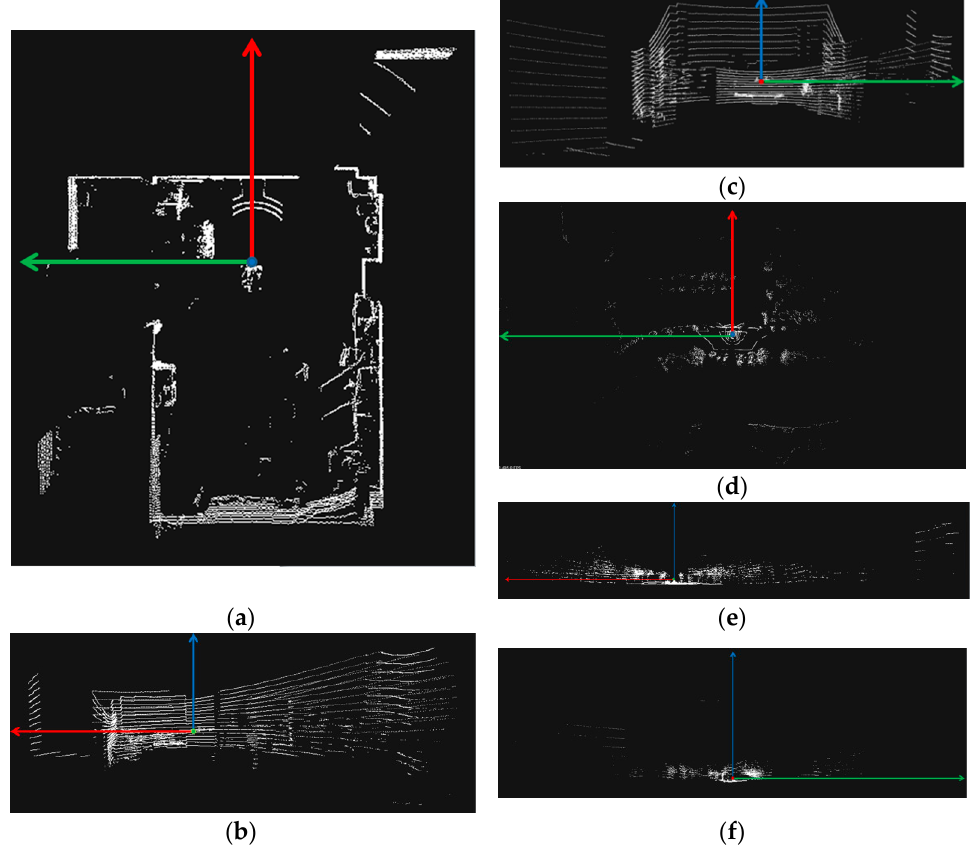
Figure 2. Raw point cloud image. ( a ) 40 cm × 40 cm x - y view; ( b ) 40 cm × 40 cm y - z view; ( c ) 40 cm × 40 cm x - z view; ( d ) 100 cm × 40 cm x - y view; ( e ) 100 cm × 40 cm y - z view; ( f ) 100 cm × 40 cm x - z view.